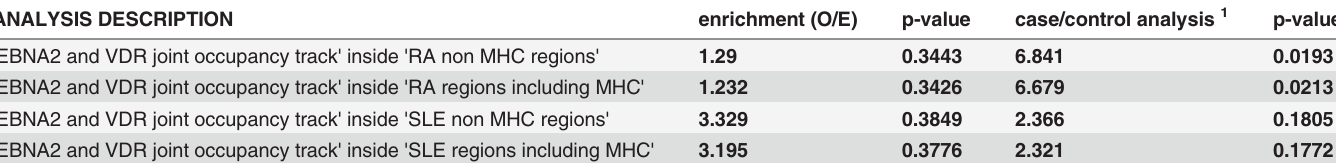
Table 5. EBNA2-VDR joint binding inside RA and SLE associated